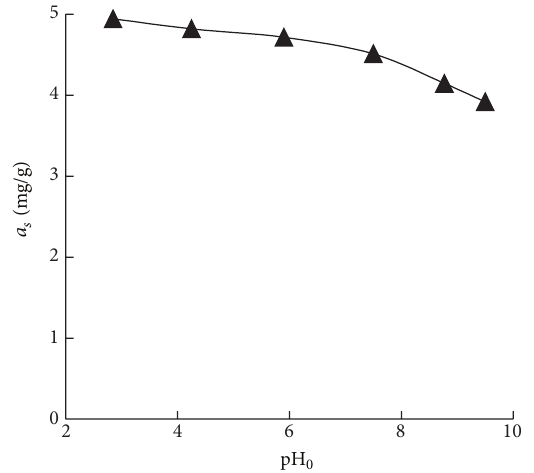
Figure 9: Effects of pH on Cr(VI) sorption with Zn 4 Al 2 O 7 from = 5.0 mg / dm 3 , 𝑚 = 0.05 g, and 𝑉 = 50 cm 3 . deionized water. 𝐶 Cr ( VI )